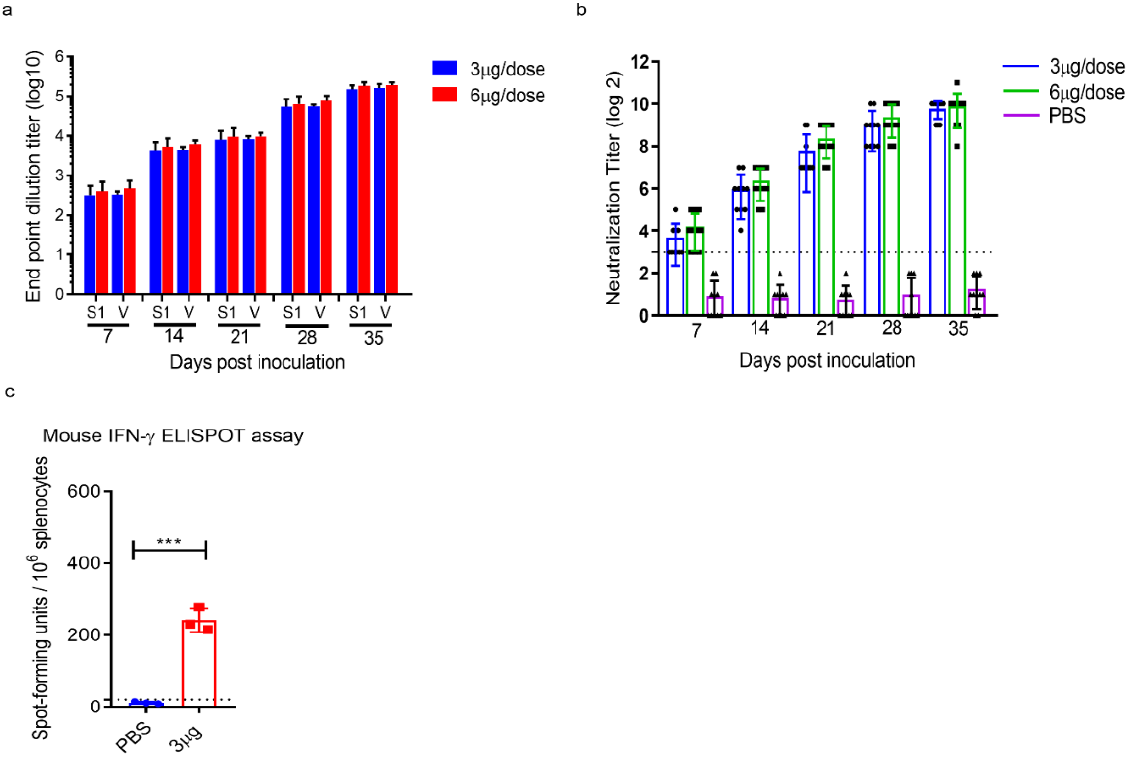
Figure 4. ERUCoV-VAC immunogenicity in K18-hACE2 transgenic mice. ( a ) Serum IgG titres were detected by SARS CoV-2 specific S1-RBD (S1) and virion (V) ELISA in vaccinated with 3 µg and 6 µg doses of ERUCoV-VAC in K18-hACE2 transgenic mice. ( b ) Serum Nab titres determined by microneutralizing assay in K18-hACE2 transgenic mice vaccinated with 3 µg and 6 µg doses of ERUCoV-VAC. ( c ) Cellular immune responses in 3 µg dose group ( n = 3) and control group ( n = 3) were analysed at day 35 following first immunization by an IFN- γ -based ELISPOT assay. The statistical significance was assessed using a two-way ANOVA test and unpaired t-test (ELISPOT); p values less than 0.01 were considered to be statistically significant significant where *** denotes 0.001; ns: not significant. Error bars represent mean ± standard deviation. The dotted line indicates the highest value measured in the normal control group.